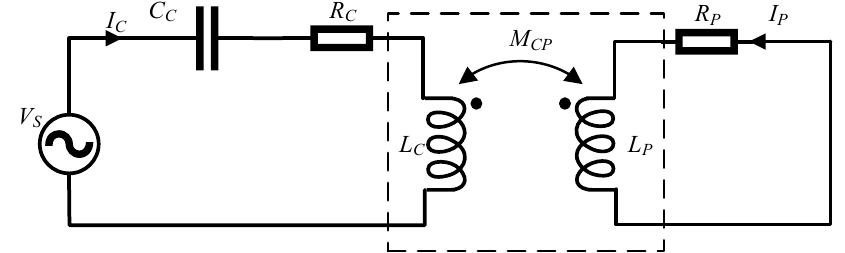
Figure 1. Equivalent circuit of single coil with aluminium plate.